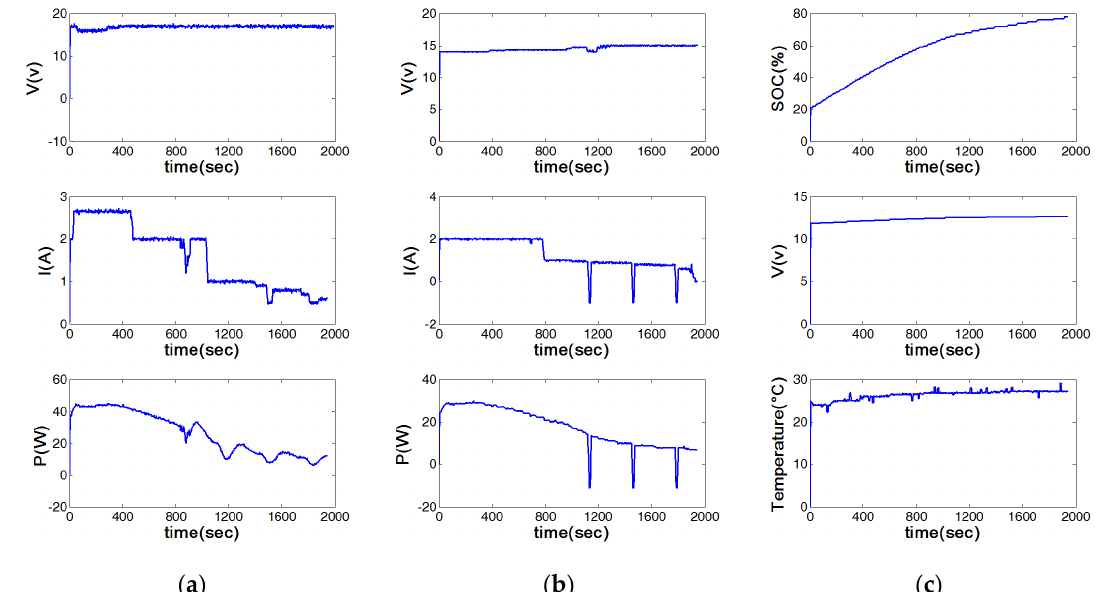
Figure 7. CV-Reflex charging. ( a ) Power end voltage, current and power curves; ( b ) battery end charging voltage, current and power curves; ( c ) SOC (%), actual voltage and temperature (°C) curves inside battery.